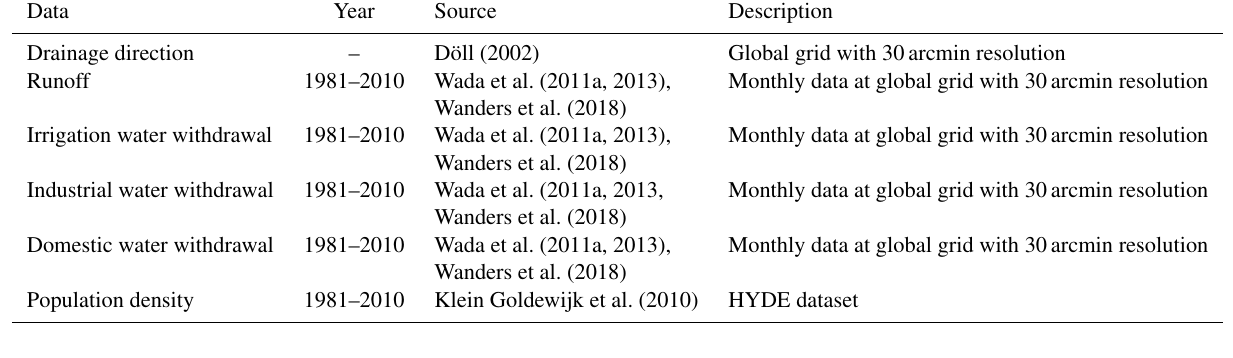
Table 2. Datasets used in the study together with their source.